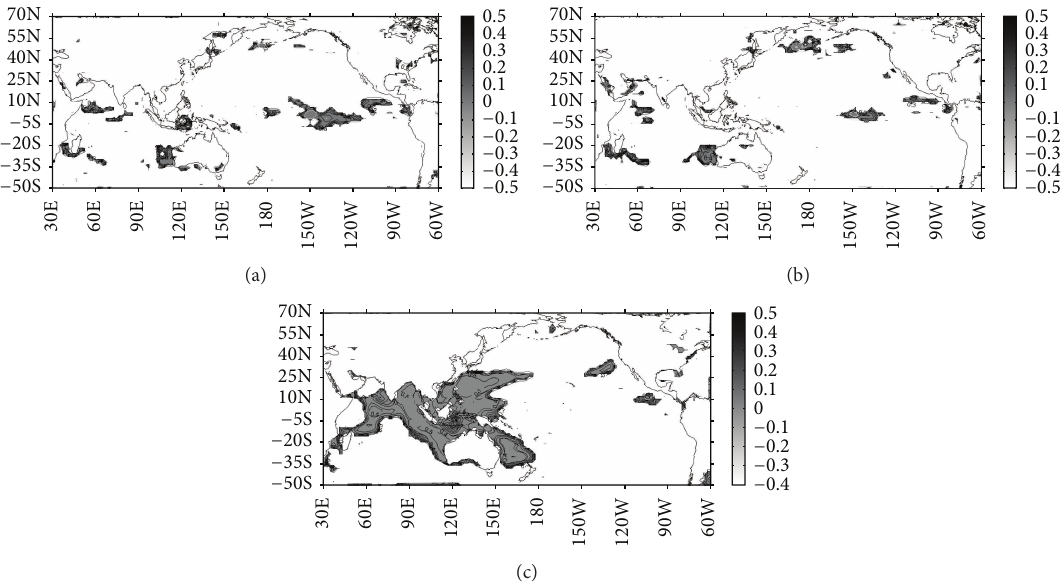
Figure 2: The spatial distribution of significant correlation coefficients between regional summer extreme precipitation indices in YRB and in-phase LHF, SHF, and SST over the global ocean. Shaded areas denote the values for correlation coefficient significance which exceed the 95% confidence level. (a), (b), and (c) represent LHF, SHF, and SST,